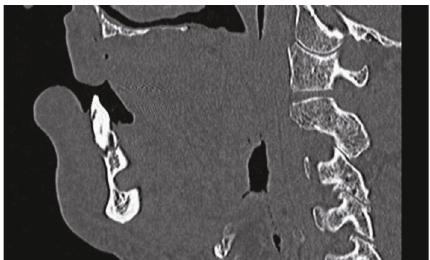
Figure 4: Magnetic resonance imaging, horizontal cross section, T1-weighted imaging. A rounded cavity is observed in the lingual side of the mandible from the right anterior to the premolar region. The margin of the cavity in the lingual side of the mandible exhibits a cortical bone structure, and the cavity ’ s margin is smooth. A layer of myeloid tissue is observed in the cavity between the lingual cortical bone and the buccal cortical bone. The tissue in the cavity in the lingual side of the mandible has similar signal intensity to the sublingual glands and is contiguous with the sublingual gland tissue.